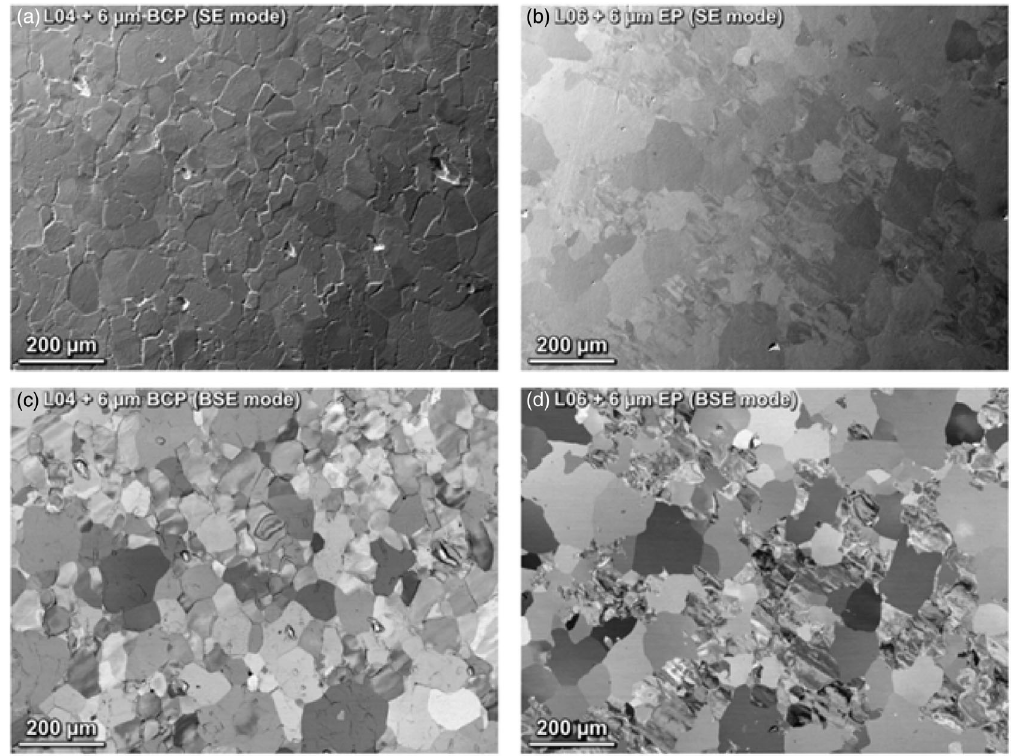
FIG. 2. (a) and (b) are SE mode SEM images of the surface after about ∼ 6 μ m surface removal from sample L04 with BCP and sample L06 with EP, (c) and (d) are their respective orientation-sensitive BSE mode images. SE mode image shows higher surface roughness on BCP treated